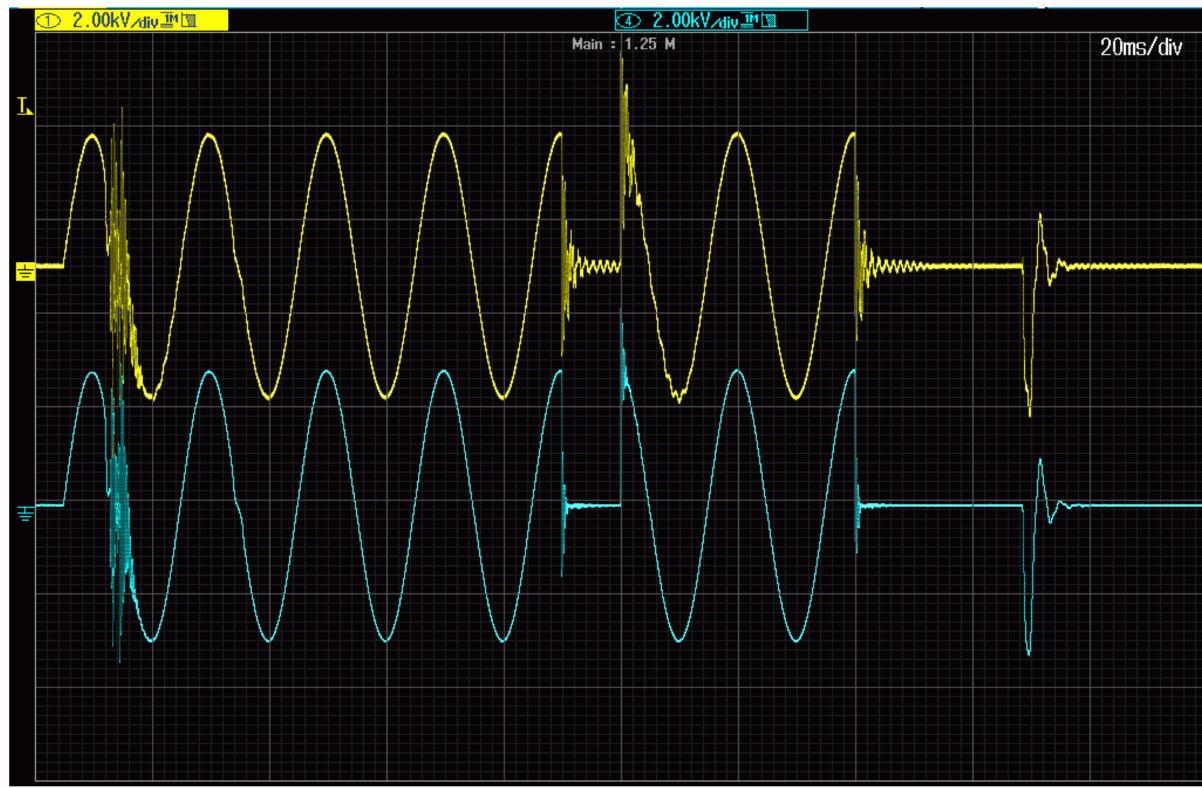
Figure 6. Voltage waveforms of voltages on primary (blue line) and secondary (yellow line) windings of the 2 kV step-up